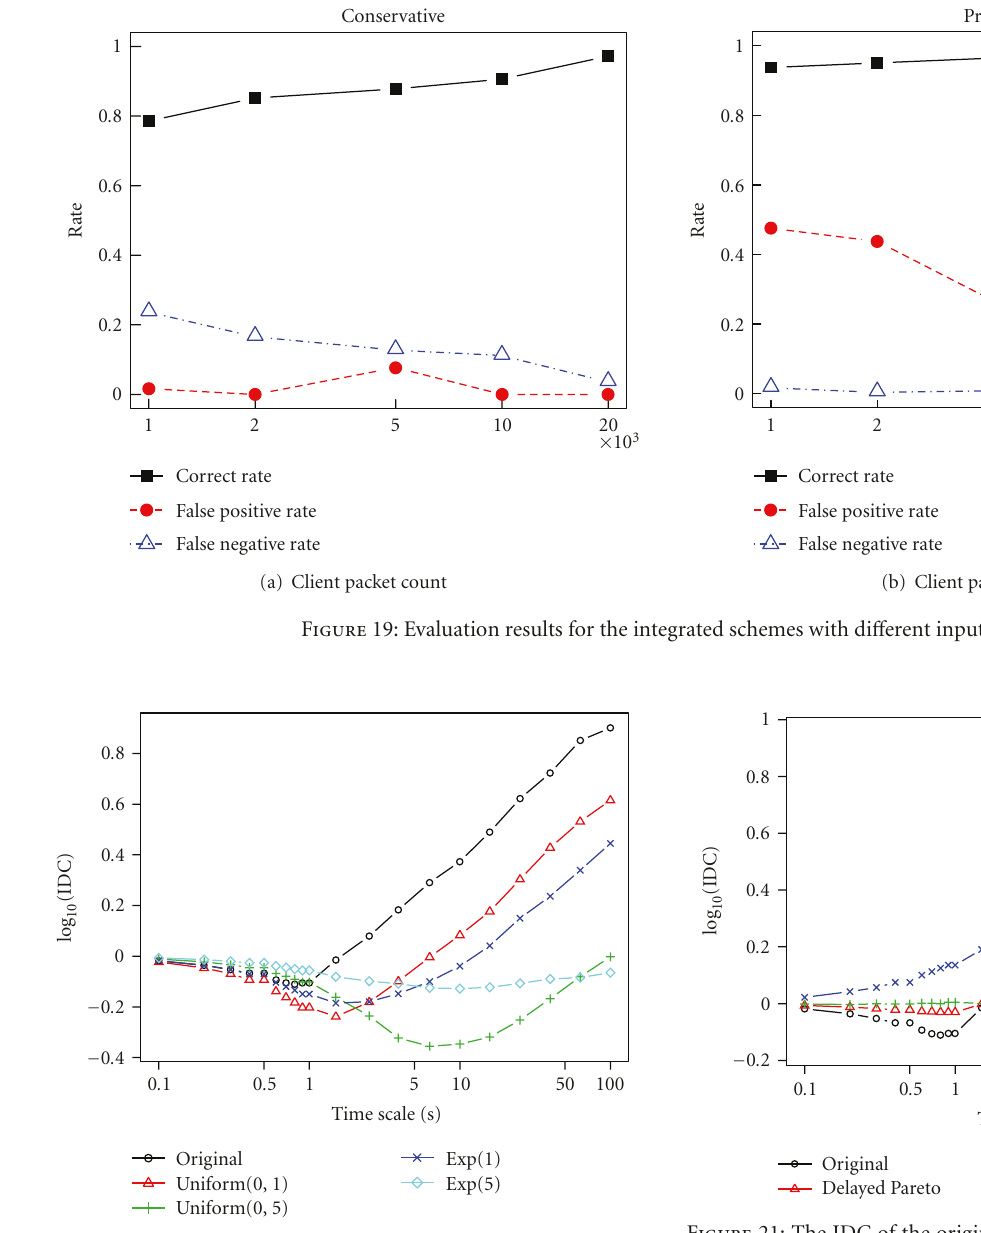
Figure 20: The IDC of the original packet arrival process in Kore1 and those of the intentionally-delayed versions.